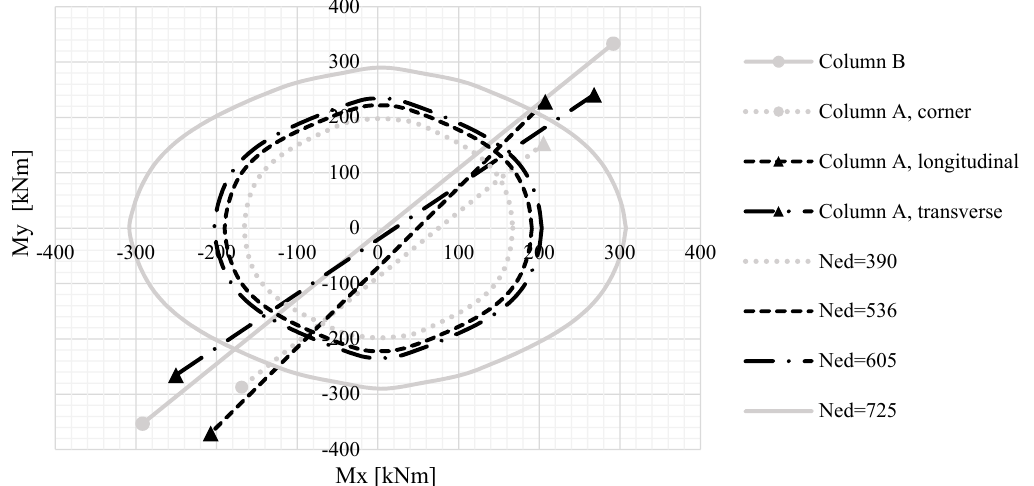
Figure 10. Resistance domains for columns of the static scheme with semi-rigid joints.